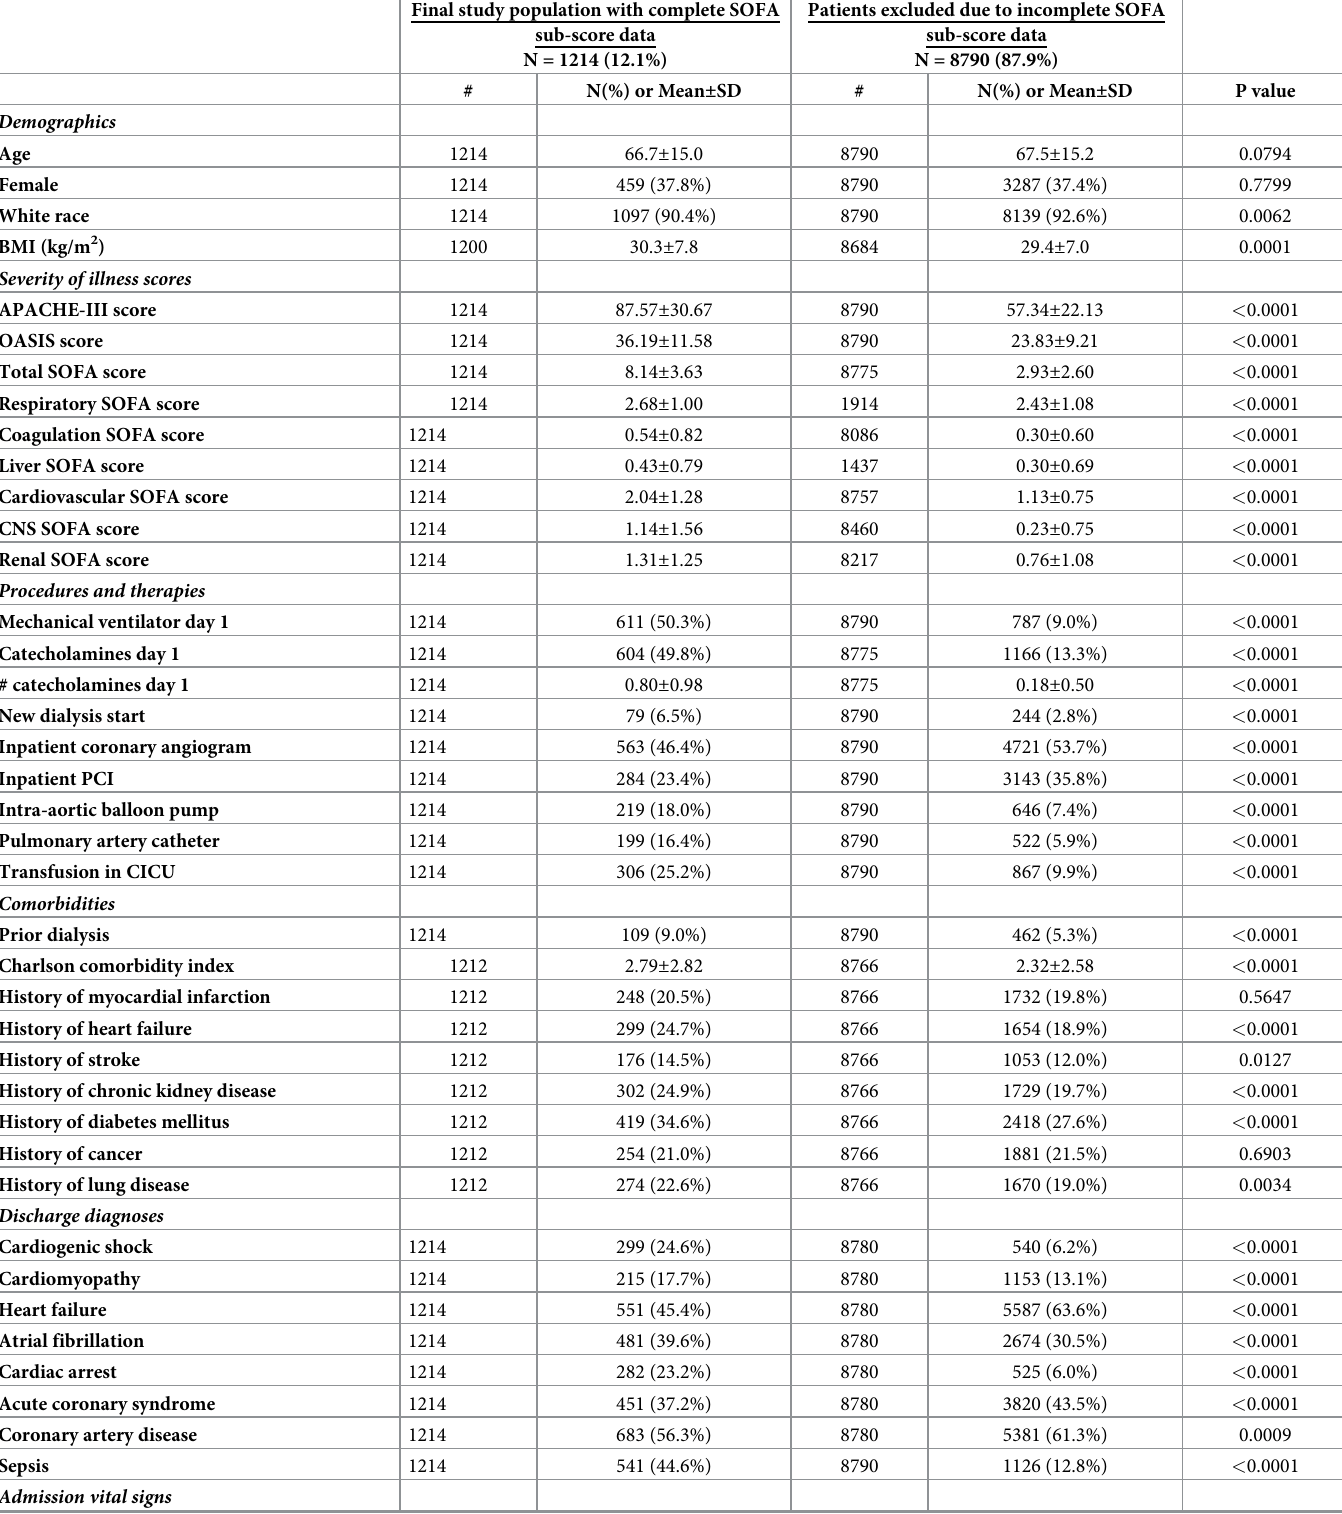
Table 1. Baseline characteristics of final study population compared to eligible patients excluded due to incomplete SOFA sub-score